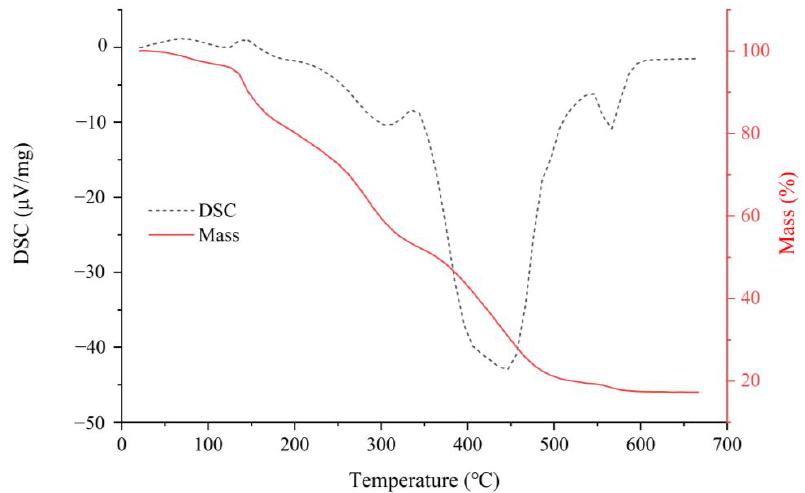
Figure 2. The TGA thermogram of crude